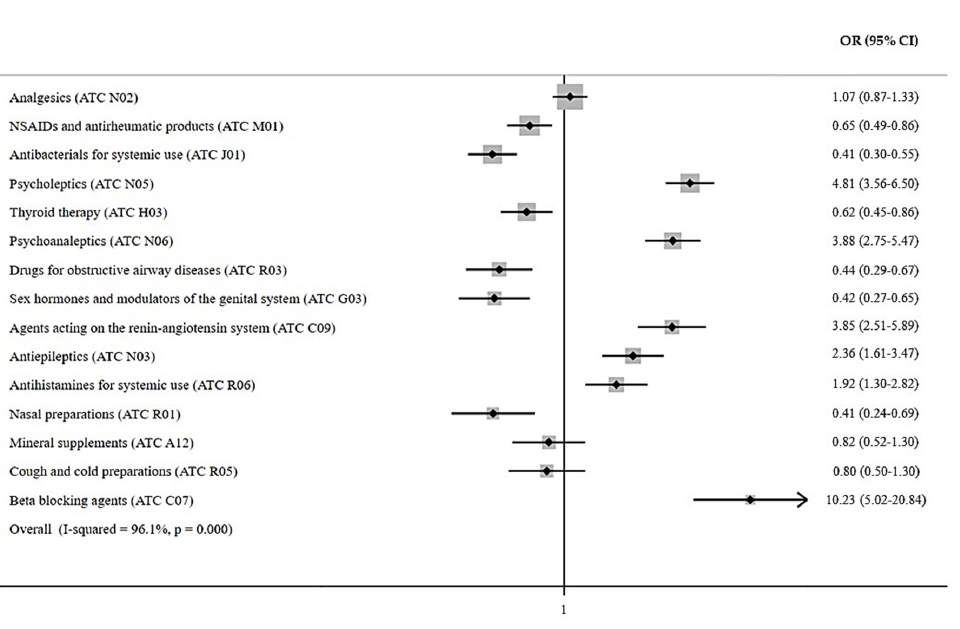
Figure 2. Risk of ED visit or hospitalization according to the most frequently reported pharmacological drug classes.